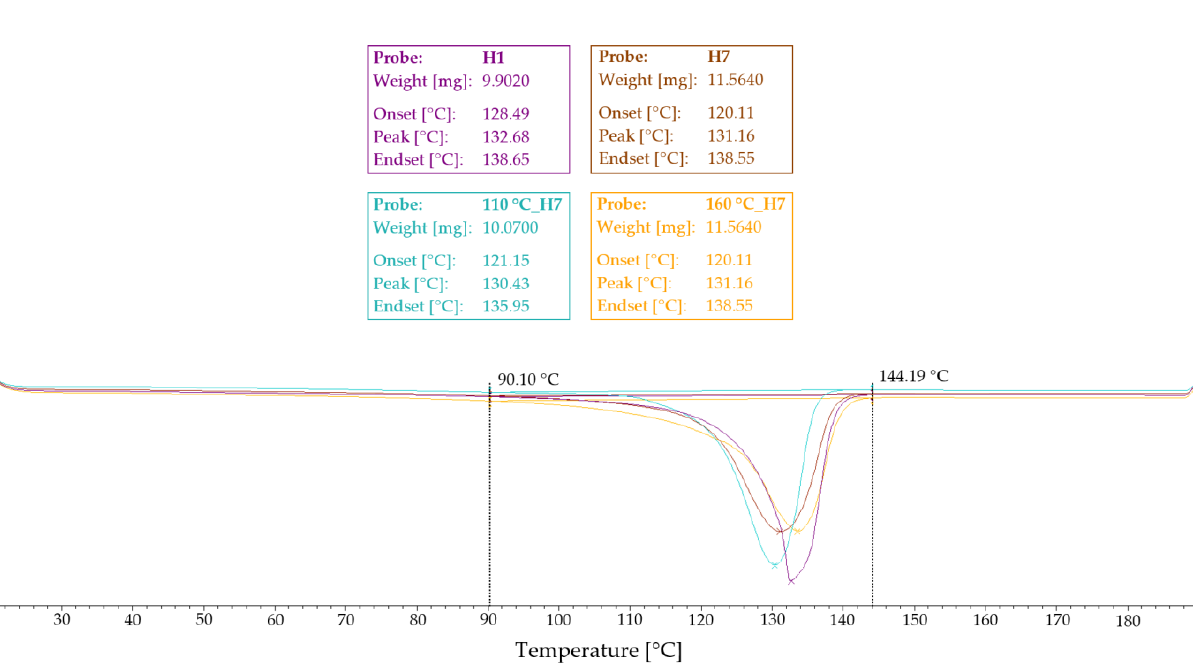
Figure 9. Deformation process of 160 °C_H7 evaluated using IR thermography.